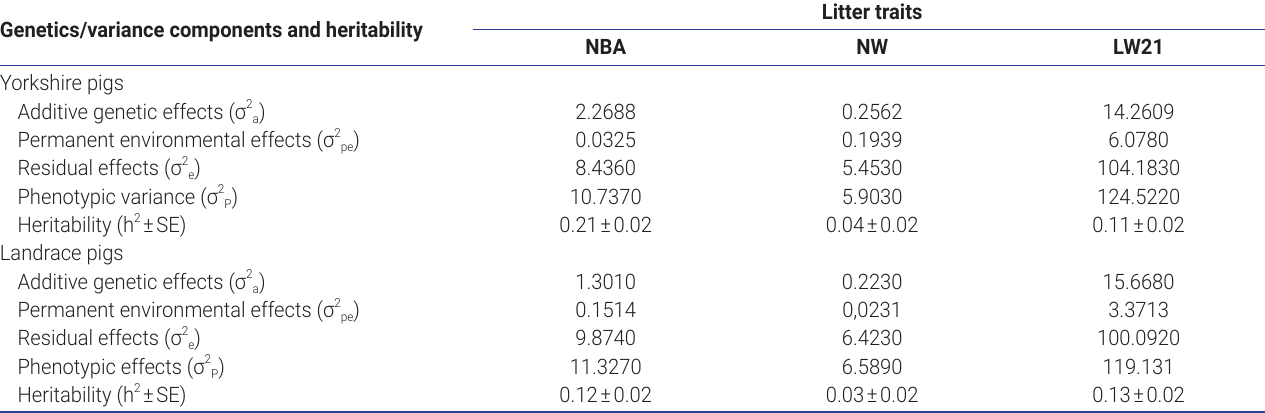
Table 3. Variance components and heritability of number born alive (NBA), number weaned (NW), and litter weight at the 21st day (LW21) in Dan- ish Yorkshire and Landrace pigs Genetics/variance components and